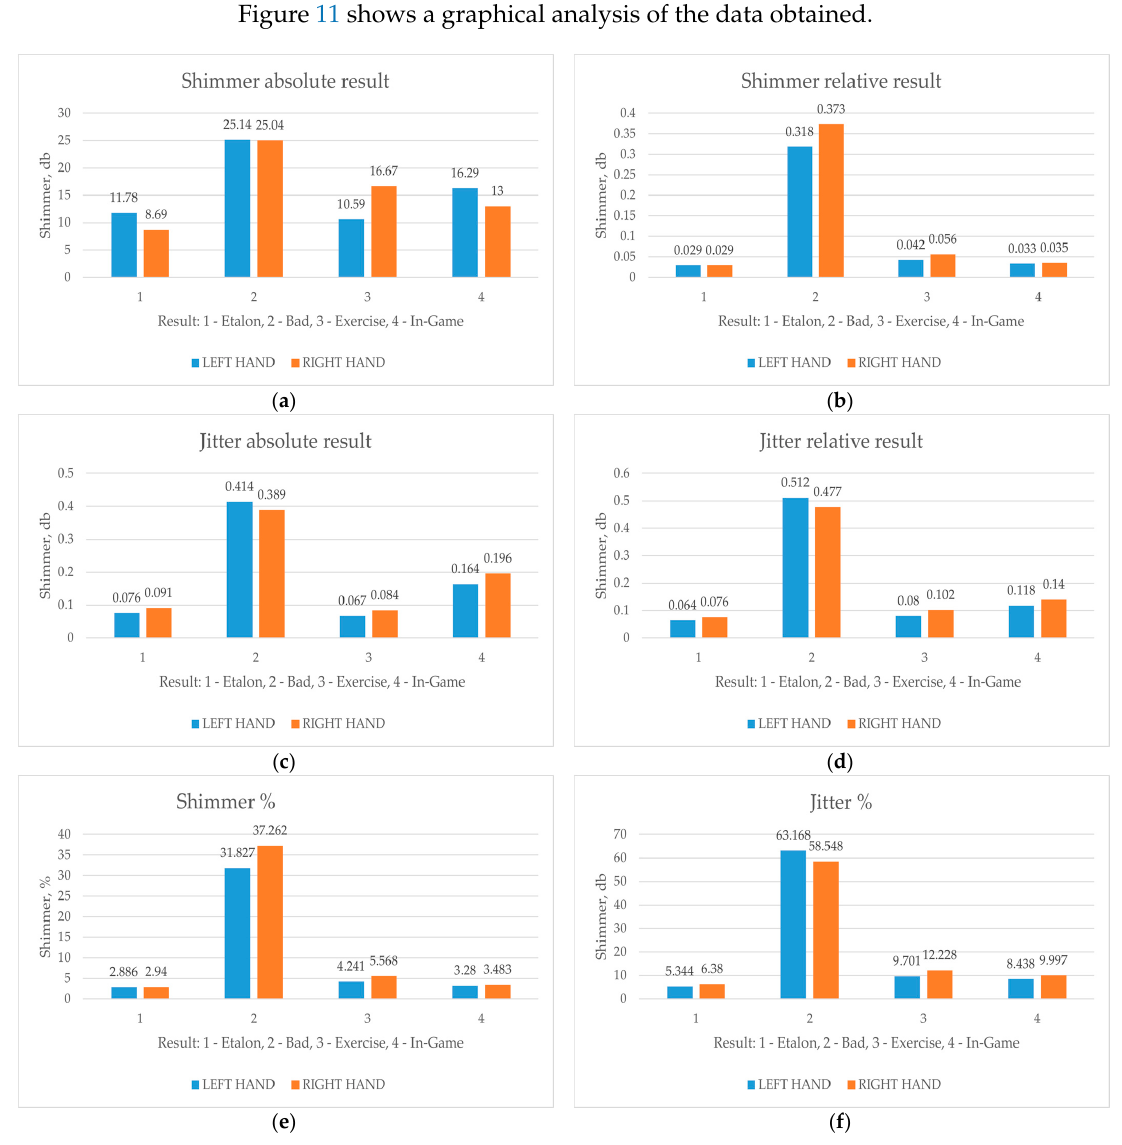
Figure 11. Visualization of the parameters of the result obtained. Where ( a )—shimmer absolute result for Exercise 3, ( b )—shimmer relative result for Exercise 3, ( c )—jitter absolute result for Exercise 3, ( d )—jitter relative result for Exercise 3, ( e )—percent of shimmer value in signal, ( f )—percent of jitter value in signal.